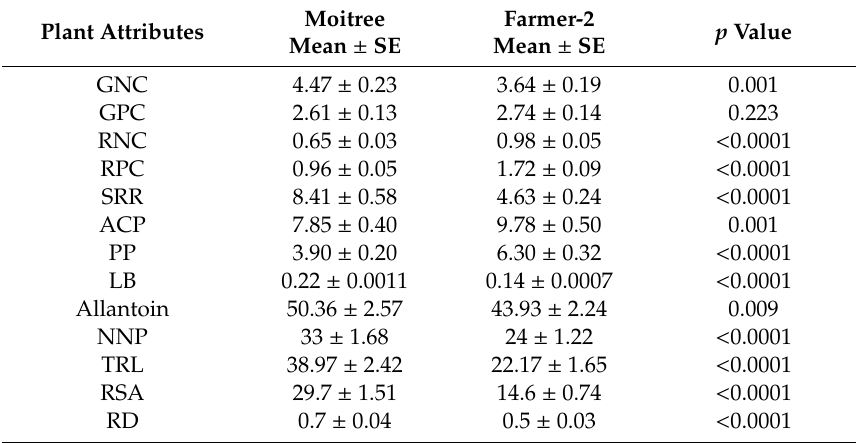
SE: standard error of mean, GNC: grain nitrogen concentration (%), GPC: grain phosphorus concentration (%), RNC: root nitrogen concentration (%), RPC: root phosphorus concentration (%), SRR: shoot–root